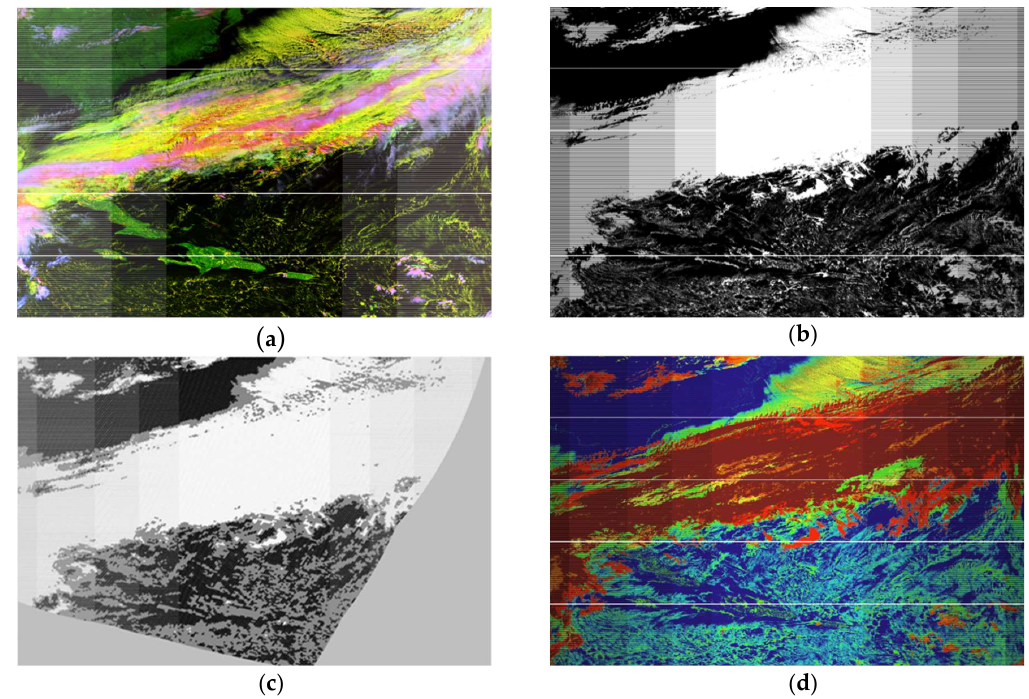
Figure 2. VIIRS products at 1757–1803 UTC on 19 Nov 2014. ( a ) The color composite of VIIRS imagery shows water clouds as yellow, ice clouds as pink-blue, land as green and ocean as black. The image was created by placing the 0.65 µm VIIRS (M5) channel in the red gun of the display, the 1.6 µm (M10) channel in the green gun and the 1.38 µm (M9) band in the blue gun. ( b ) The manually generated cloud mask (MGCNC) of VIIRS imagery at 1815 UTC on 18 Nov 2014, where clouds are white and cloud free pixels are black, ( c ) the mean cloud cover fraction (CCf) truth (CCf truth) from mapping MGCNC to NAM grid and ( d ) VIIRS cloud mask (VCM) phase shows water clouds as green, ice clouds as red (thin cirrus), brown (overlap of cirrus with lower-level water clouds) and orange (opaque cirrus). Mixed phase (ice and water) clouds are yellow. Light blue shows sub-pixel water cloud edges.